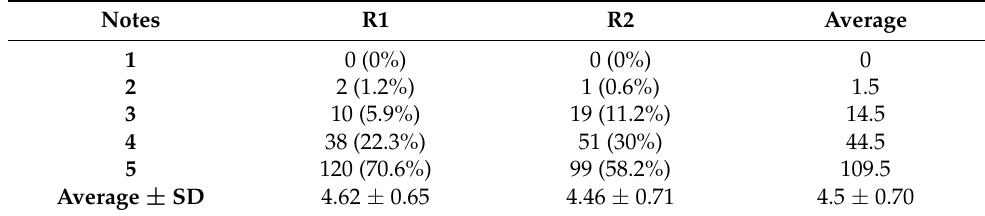
Table 3. Distribution of ratings for subjective image